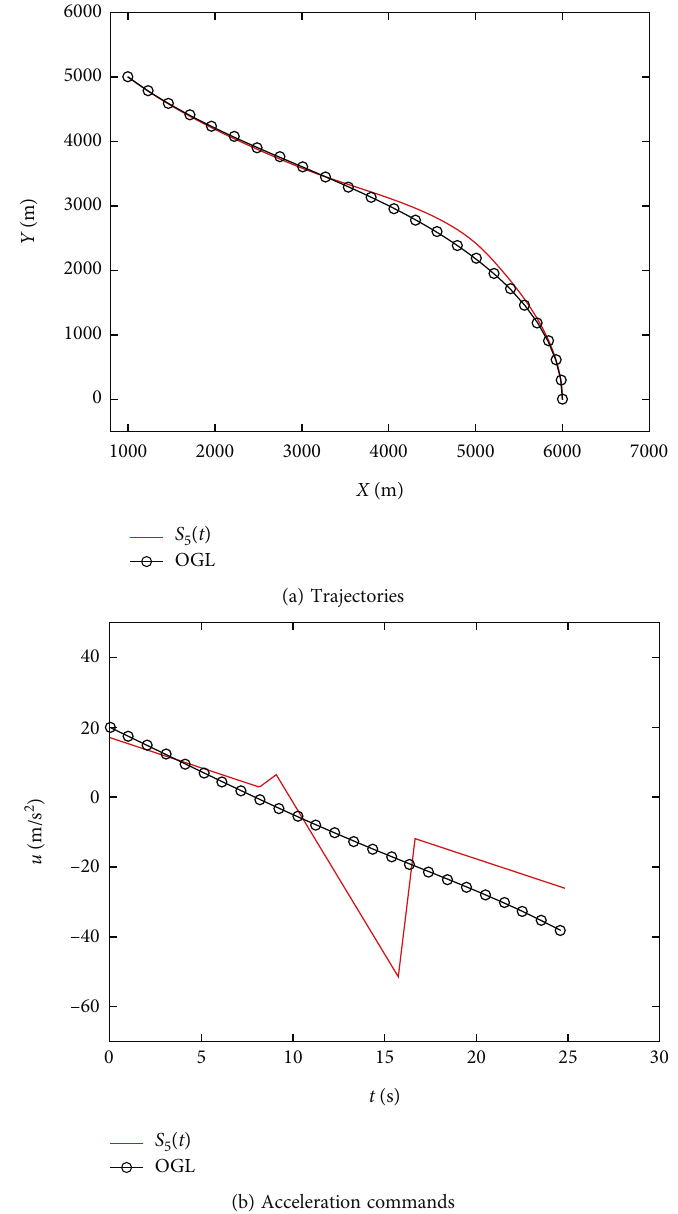
ð 0 Þ = − 45 ° , γ = − 90 ° m f